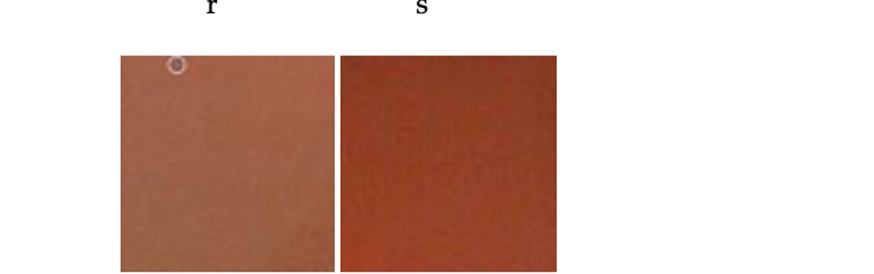
mixture fired at ( r ) 1200 ◦ C/2 h; ( s ) 1200 ◦ C/6 h. fired at ( r ) 1200 °C/2 h; ( s ) 1200 °C/6 h. fired at ( r ) 1200 °C/2 h; ( s ) 1200 °C/6 h. fired at ( r ) 1200 °C/2 h; ( s ) 1200 °C/6 h.